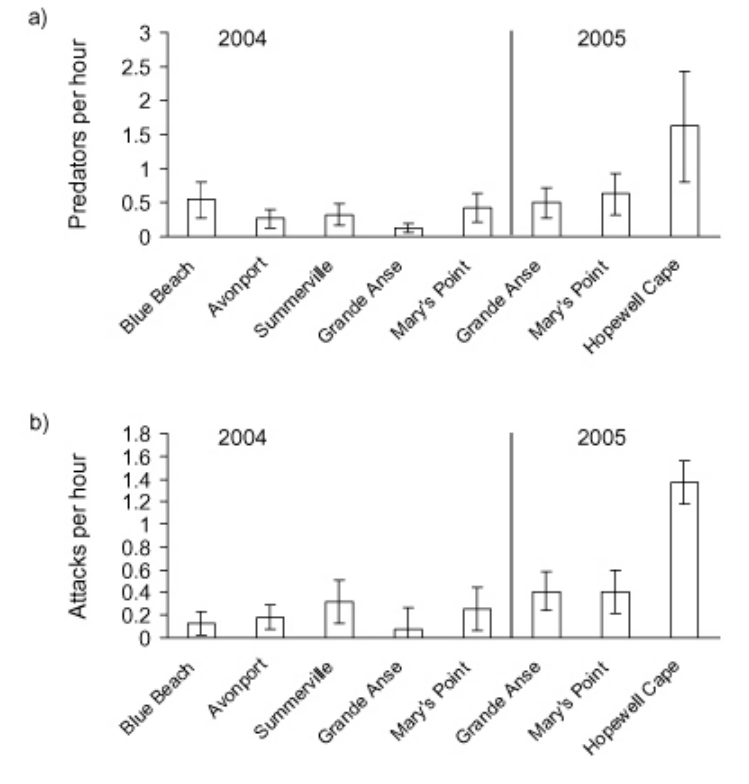
Fig. 6. Number of (a) predators per hour and (b) attacks per hour noted during each high-tide observation period at each site in each year of the study ( n = 4). Error bars are ± 1